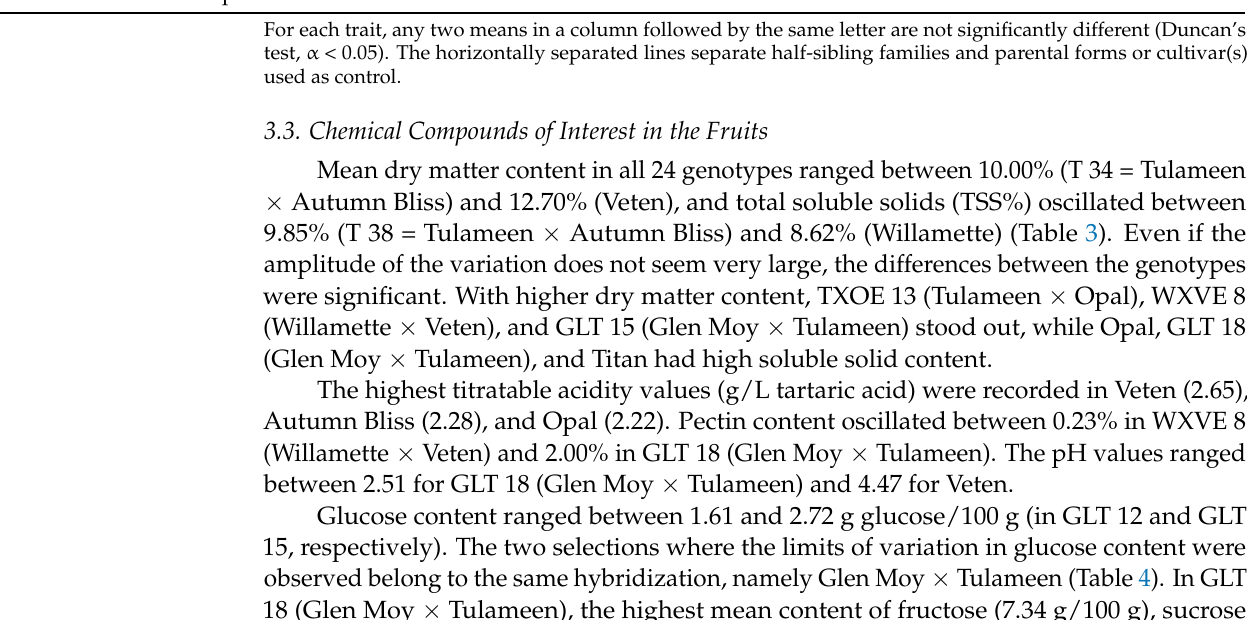
For each trait, any two means in a column followed by the same letter are not significantly different (Duncan’s test, α < 0.05). The horizontally separated lines separate half-sibling families and parental forms or cultivar(s) used as